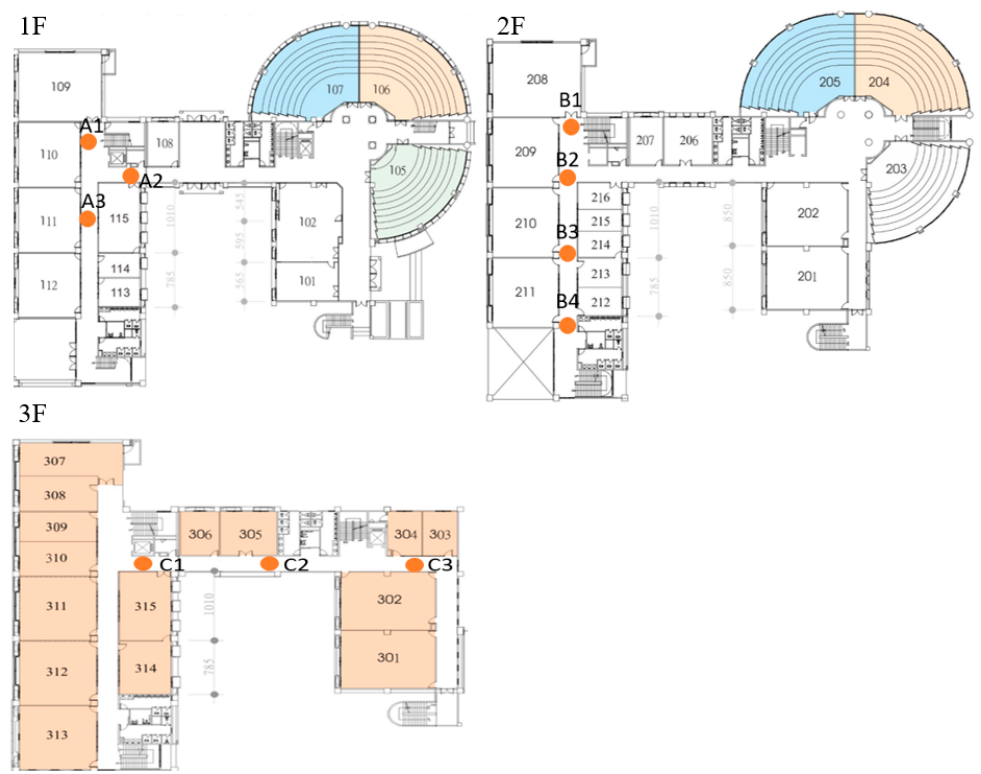
Figure 10. The deployment maps of Lbeacons in EB-No. 5 at Yuntech.